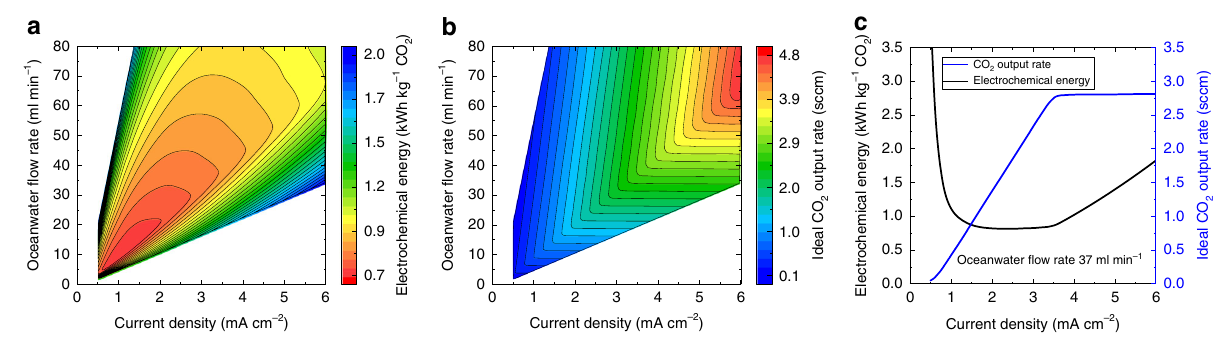
Fig. 3 Optimization of BPM electrodialysis operating conditions. a Contour plots of the calculated electrochemical energy consumption for CO 2 capture (kWh kg − 1 ) and b the calculated rate of ideal CO 2 output from the BPM electrodialysis cell as a function of the applied current density and the input oceanwater fl ow rate. The BPM electrodialysis cell has an active electrode and membrane area of 64 cm 2 . c The calculated electrochemical energy consumption and the ideal CO 2 output rate as a function of the operating current density at an oceanwater fl ow rate of 37 ml min −